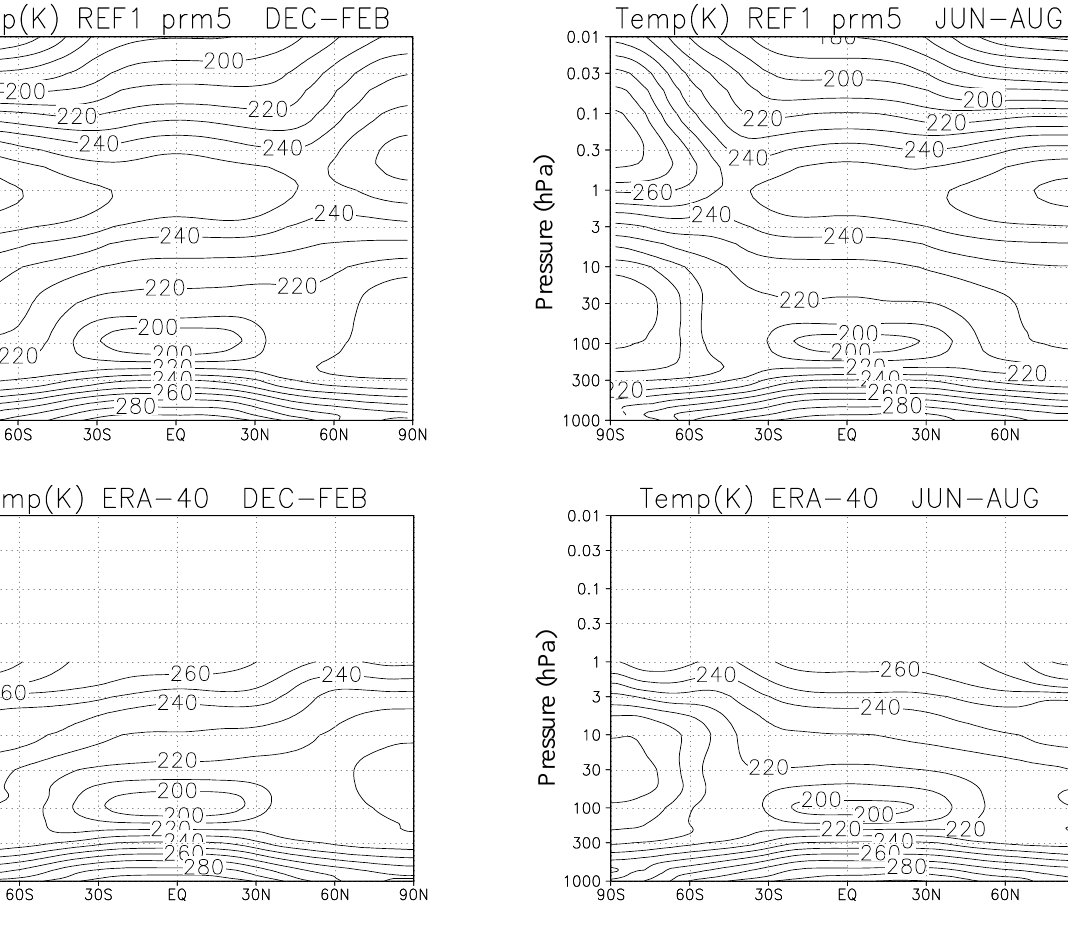
Fig. 1b. Same as in Fig. 1a but for temperature and contour intervals of Fig.1b Same as in Fig.1 but for temperature and contour intervals of 10 K.